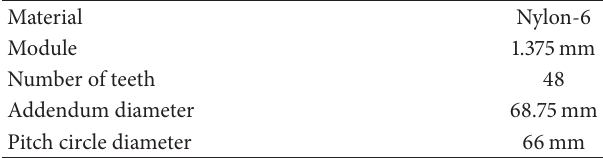
Table 4: Internal gear ring specification.